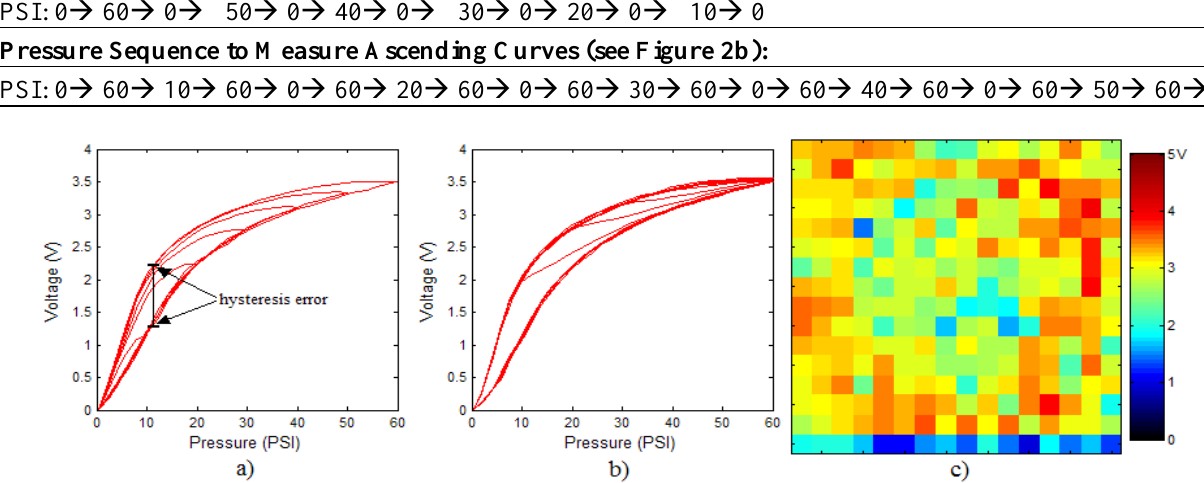
Table 1. Pressure sequences to measure hysteresis loops of the tactile sensor based on a printed circuit board (PCB). Pressure Sequence to Measure Descending Curves (see Figure 2a):